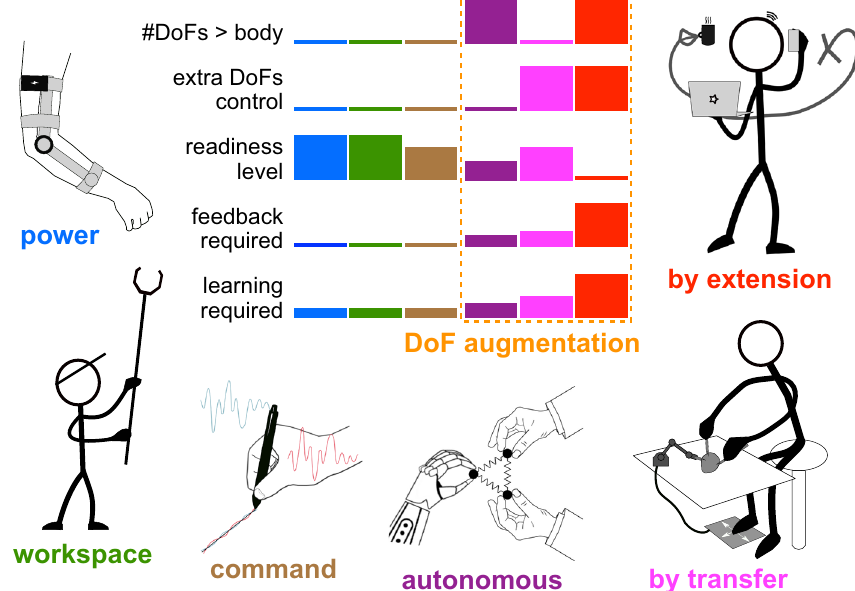
Fig. 2 Schematic overview of the different concepts of human movement augmentation and qualitative analysis of major characteristics. The logos for each form of augmentation ( fi gures by Camille Blondin) illustrate example applications. The fi ve histograms correspond to whether or not the form of augmentation grants the user more DoFs than their body and provides them with explicit control, as well as the level of how ready each device is for widespread usage, and how much feedback and learning would be